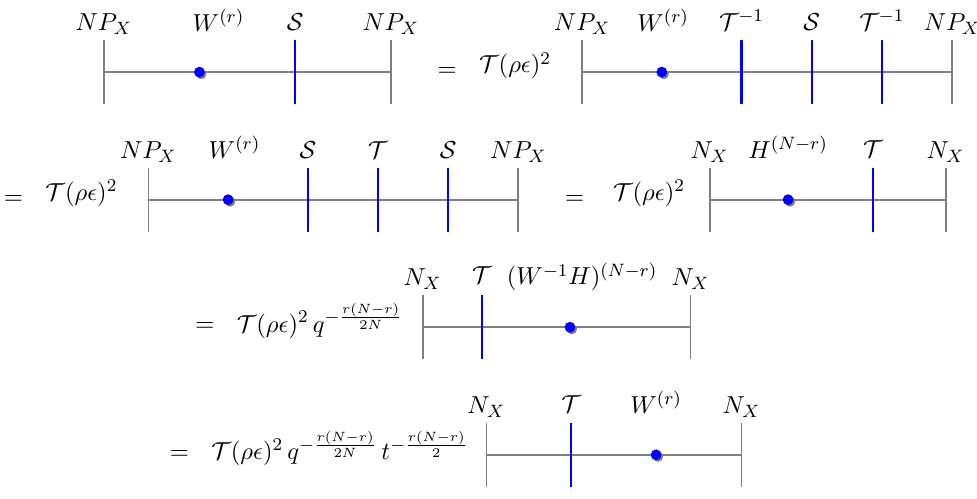
Figure 18 . Sequence of moves to evaluate Z